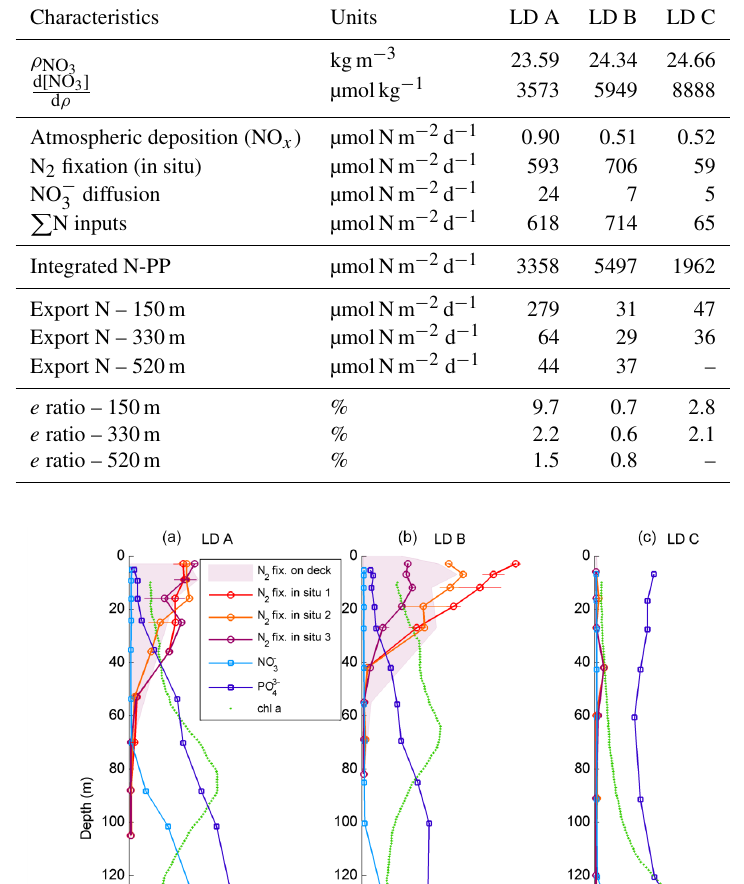
Table 2. Mean daily N budget at the three stations LD A, LD B and LD C.